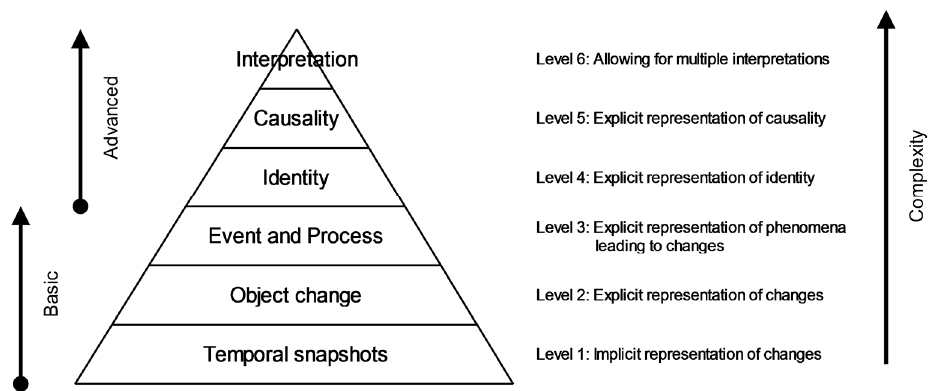
Figure 1. Pyramid of functionality levels.